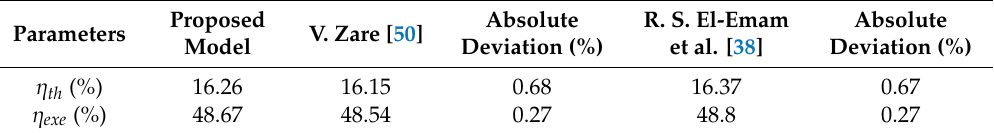
Table 4. Validation of the proposed model for the RORC system.